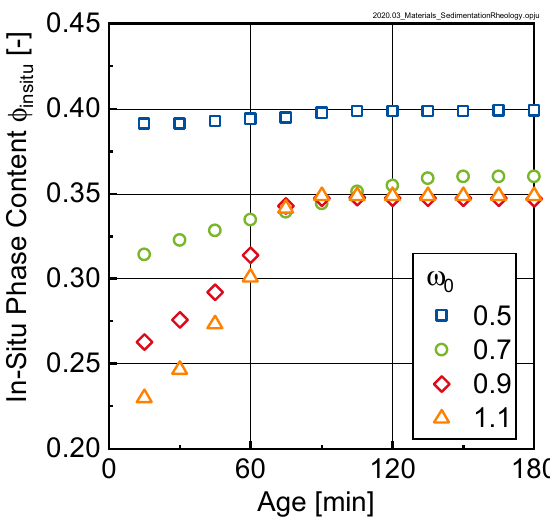
Figure 7. In-situ phase content φ insitu of mixes with di ff erent initial w / c-ratios and corresponding initial phase contents ω 0 as calculated according to Equation (3).